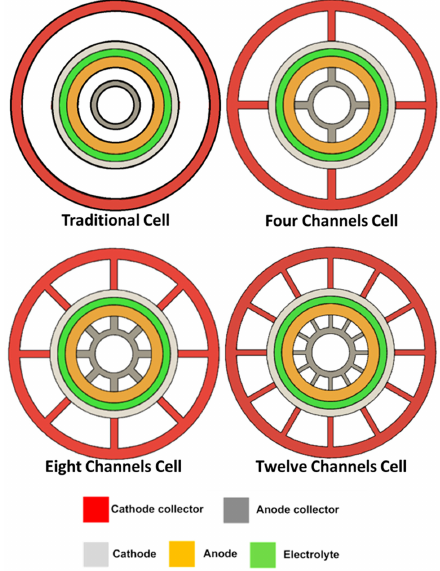
Figure 5. Validation of the numerical result with the experimental result. Figure 6. Investigated current collector designs (front view).